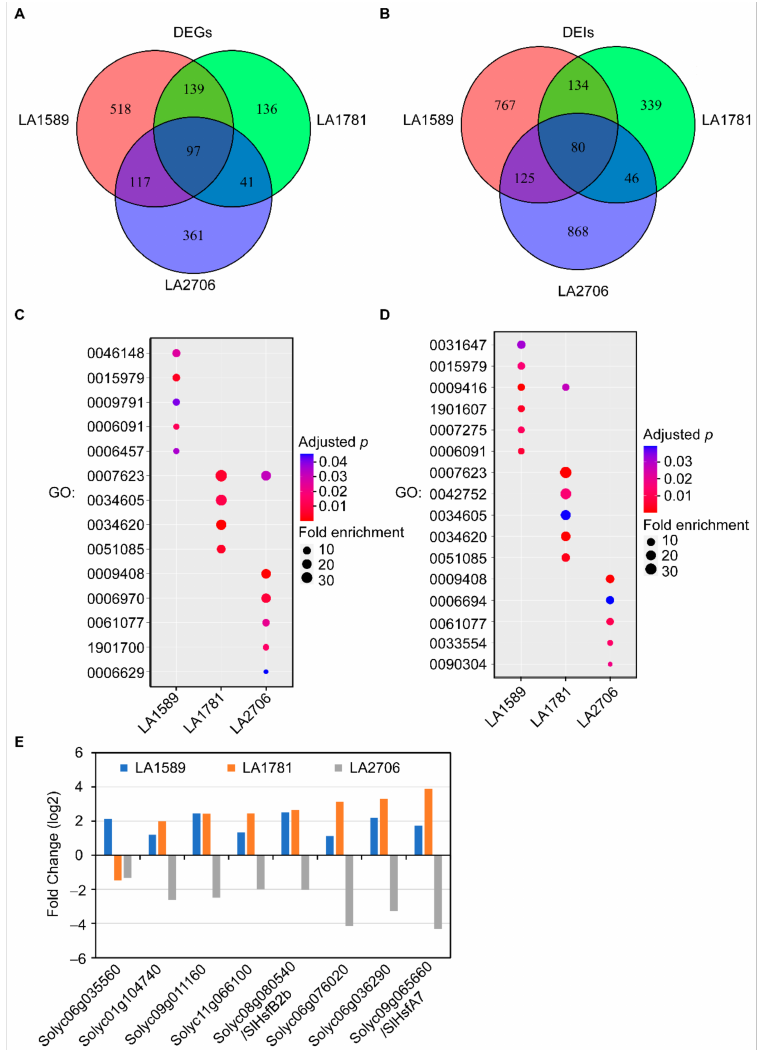
Figure 6. Comparison of gene expression in response to growth conditions in LA1589, LA1718 and LA2706. ( A ), A Venn diagram showing DEGs identified in the inflorescences of LA1589, LA1781 and LA2706 (Moneymaker) in response to changing growth conditions. ( B ), A Van dia- gram showing DEIs identified in the inflorescences of LA1589, LA1781 and LA2706 (Moneymaker) in response to changing growth conditions. ( C ), Gene ontology analysis of DEGs. ( D ), Gene on- tology analysis of DEIs. DEGs and DEIs were identified by comparison of expression values be- tween open field and plastic greenhouse. ( E ), Distinctive response of gene expression between LA2706 and its ancestral relatives. Following are the GO term names for the GO IDs present in ( C , D ): pigment biosynthetic process (GO:0046148), photosynthesis (GO:0015979), post-embryonic development (GO:0009791), generation of precursor metabolites and energy (GO:0006091), protein folding (GO:0006457), circadian rhythm (GO:0007623), cellular response to heat (GO:0034605), cel- lular response to unfolded protein (GO:0034620), chaperone cofactor-dependent protein refolding (GO:0051085), response to heat (GO:0009408), response to osmotic stress (GO:0006970), chaperone- mediated protein folding (GO:0061077), response to oxygen-containing compound (GO:1901700), lipid metabolic process (GO:0006629), regulation of protein stability (GO:0031647), response to light stimulus (GO:0009416), alpha-amino acid biosynthetic process (GO:1901607), multicellular organ- ism development (GO:0007275), regulation of circadian rhythm (GO:0042752), steroid biosynthetic process (GO:0006694), cellular response to stress (GO:0033554) and nucleic acid metabolic process (GO:0090304). Only the narrowest GO terms were present in ( C , D ); complete lists of enriched GO terms can be found in Supplementary Figures S2 and